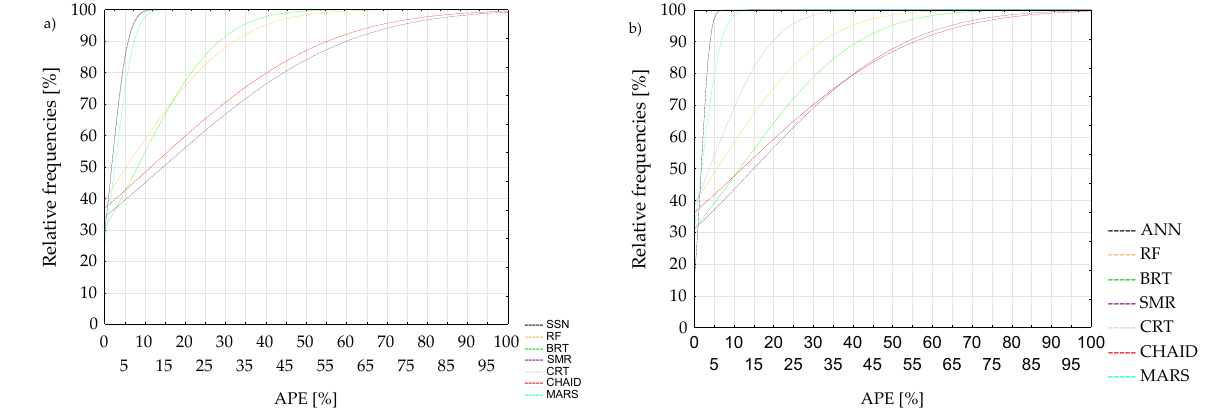
Figure 5. Empirical distributors of APE errors of the stored energy models in the PCM battery deter-